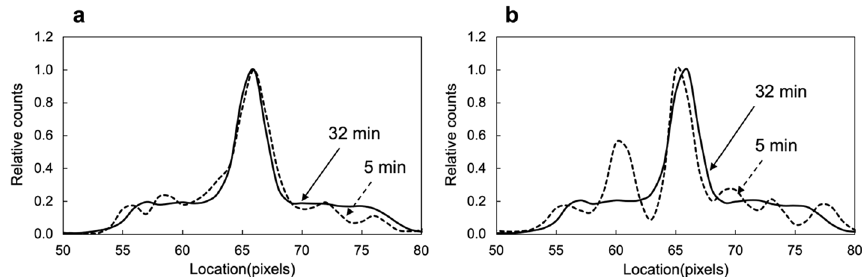
Fig. 8 Comparison of line profile curves between short-time and longtime scans for a SwiftScan SPECT and b step and shoot mode (SSM). The solid line indicates a longtime scan (5 min) and the dashed line indicates a short-time scan (32 min)